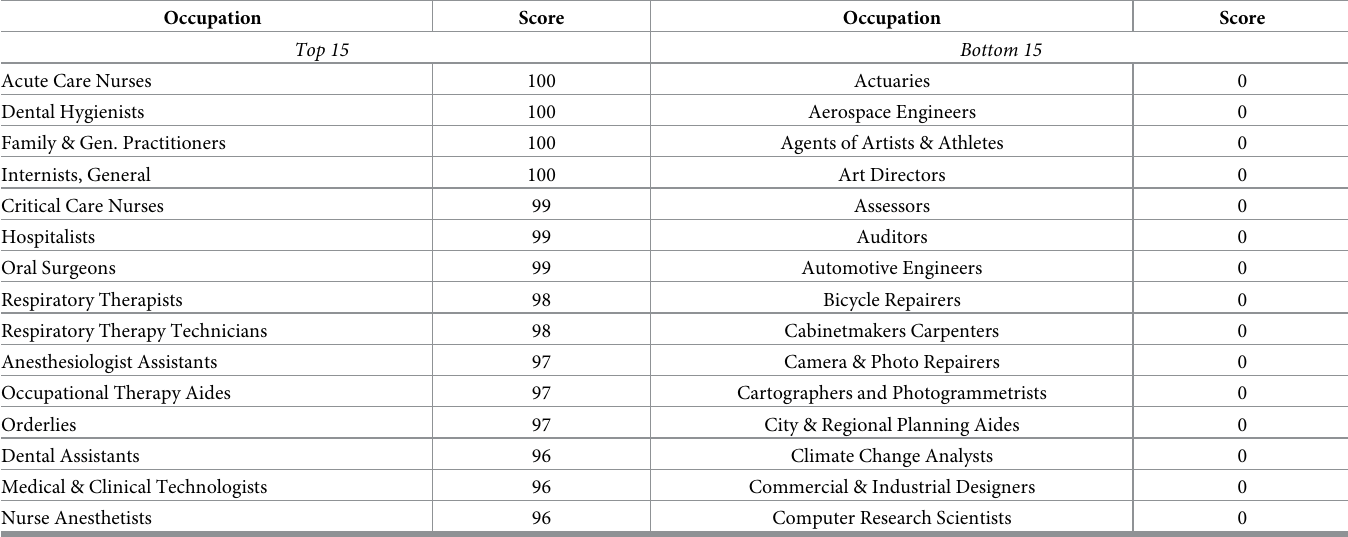
Table 2. Index for exposure to